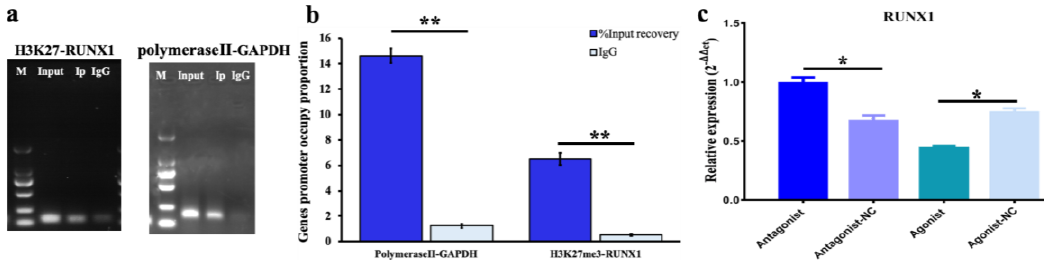
Figure 4. The ChIP-PCR of H3K27me3 in pGCs. (a) The occupation of RNA polymerase Ⅱ and H3K27me3 in GAPDH and the RUNX1 promoter by was quantified by assessing the ChIP-PCR products. M denotes DNA marker 2000. (b) The plot of the promoter occupancy of a proportion of GAPDH and RUNX1 in the percent of Input recovery and IgG in each ChIP-PCR with the 2 −ΔΔ ct method. The * indicates p < 0.05 and ** indicates p < 0.01. (c) qPCR assay showing the regulation of RUNX1 by H3K27me3.